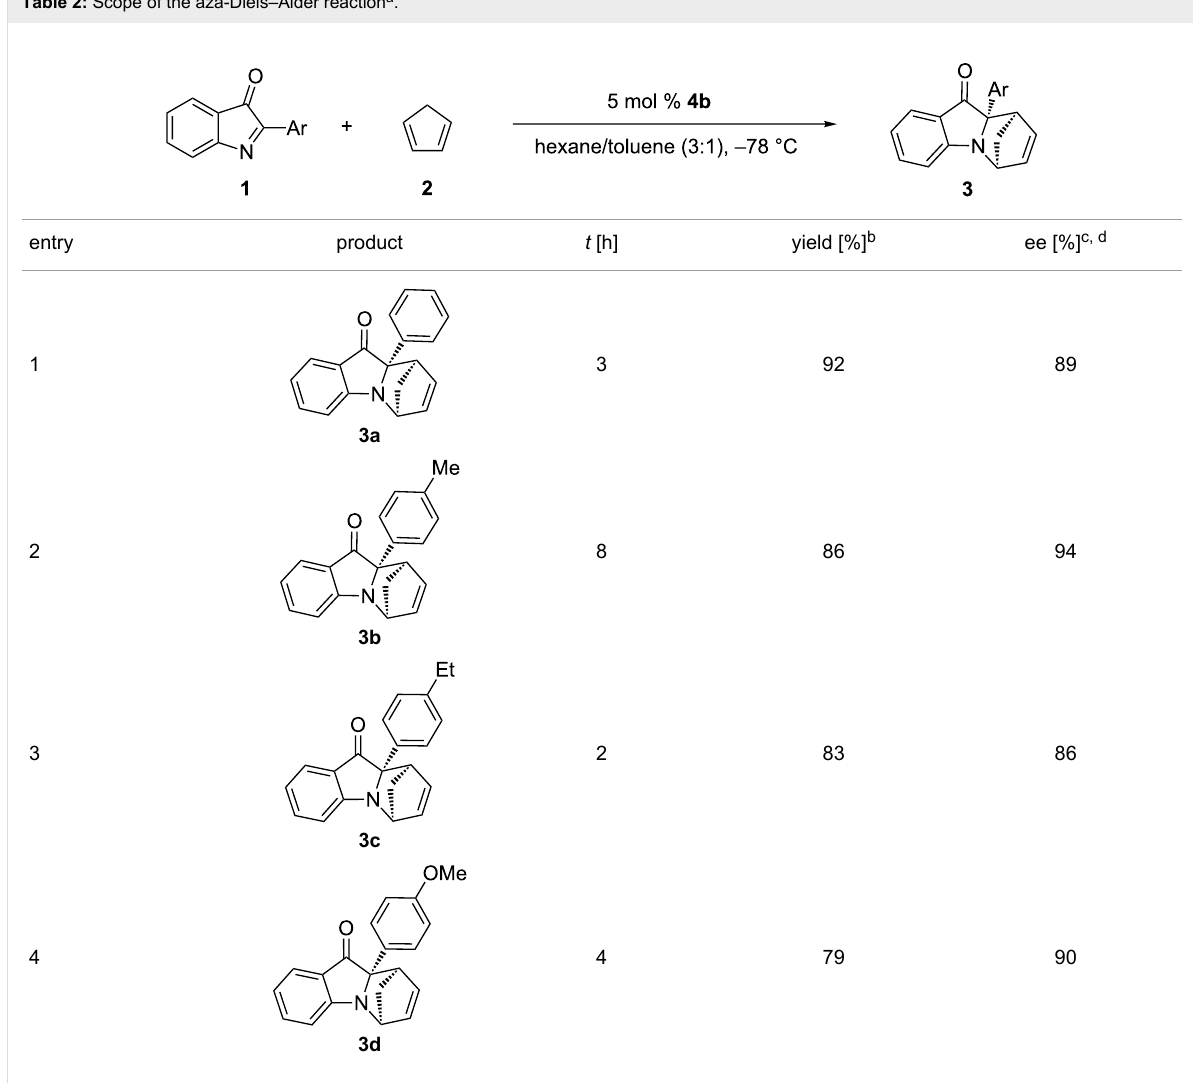
Table 2: Scope of the aza-Diels–Alder reaction a